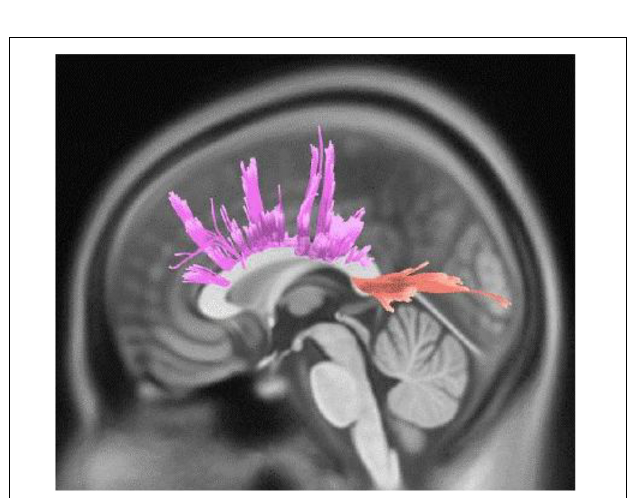
FIGURE 2 | White matter pathways with significantly negative association with Active engagement in female participants (FDR = 0.046).